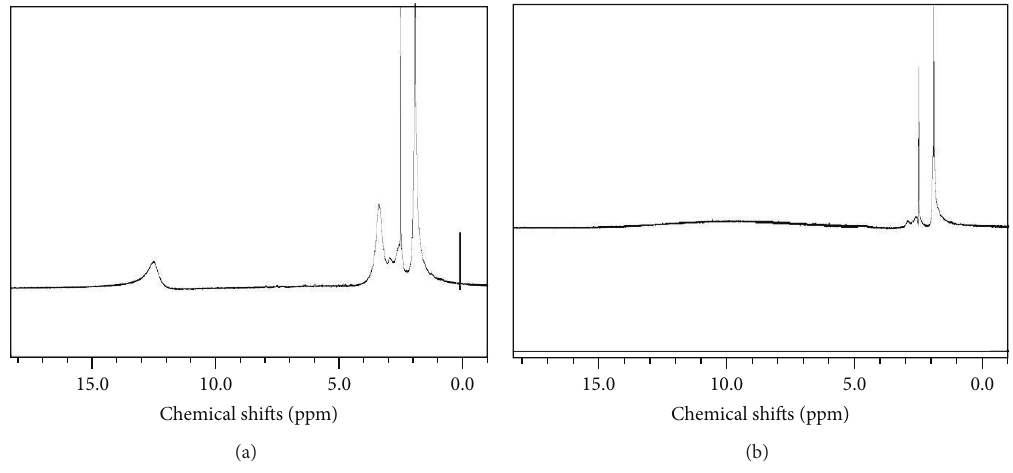
Figure 1: 1 HNMR spectra of VA: MA having monomer feed compositions (a) (1: 2) and (b) (1:1).